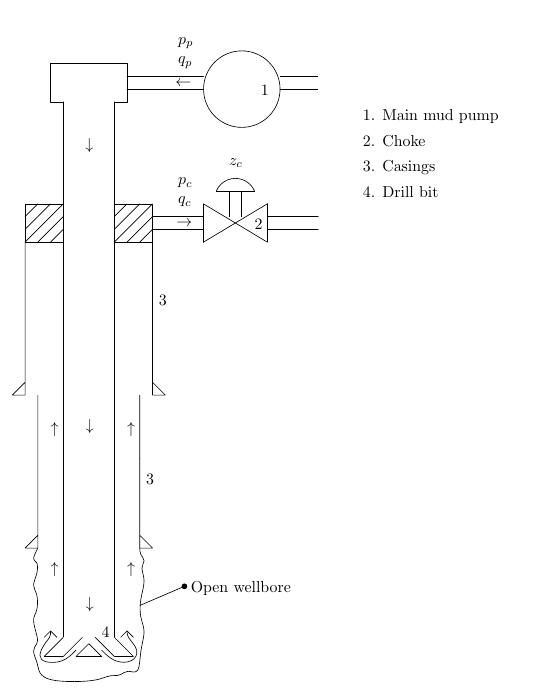
Figure 1: Schematic of ABP-MPD. The mud flow is in- dicated by